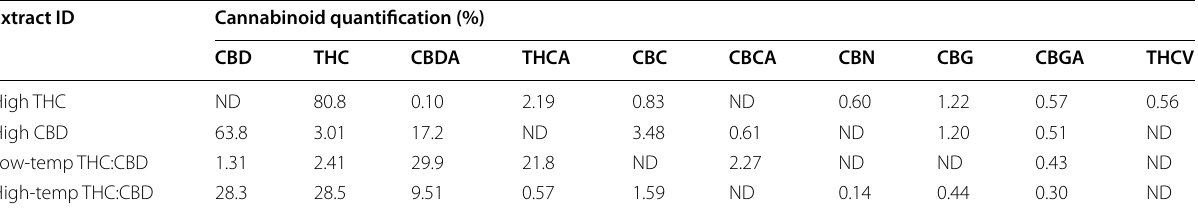
Table 1 Analysis of the average cannabinoid concentrations in extracts prepared from different cannabis chemotypes as measured by LC‑HRMS (%). ND not detectable Extract ID Cannabinoid quantification